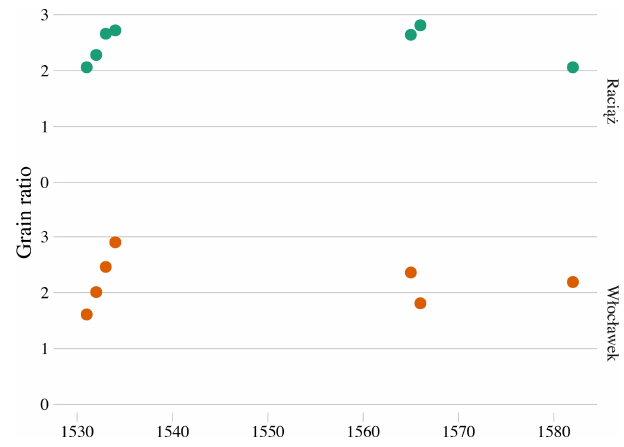
Figure 7. Grain yield ratio in the estates of Bishops of Włocławek. Source: ˙Zytkowicz